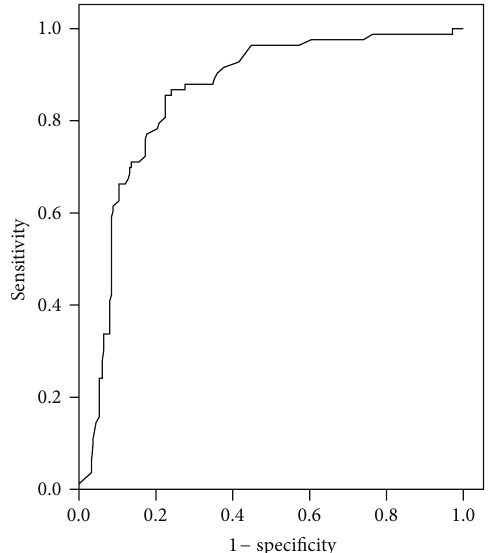
Figure 5: Receiver operating characteristic (ROC) curve of placen- tal growth factor (PlGF) in the prediction of preeclampsia. Area under the curve (AUC) = 0.863 (95% CI: 0.818 to 0.907; 𝑃 < 0.0001 ).